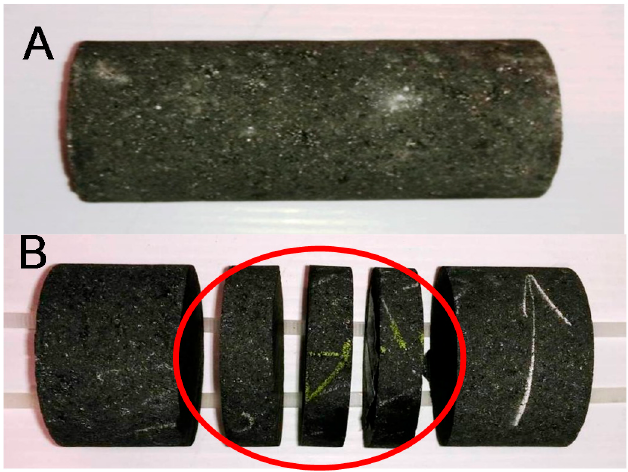
Figure 3. Anode core shapes for measuring electrical resistivity using the standard method ( A ) and the Van der Pauw method ( B ).